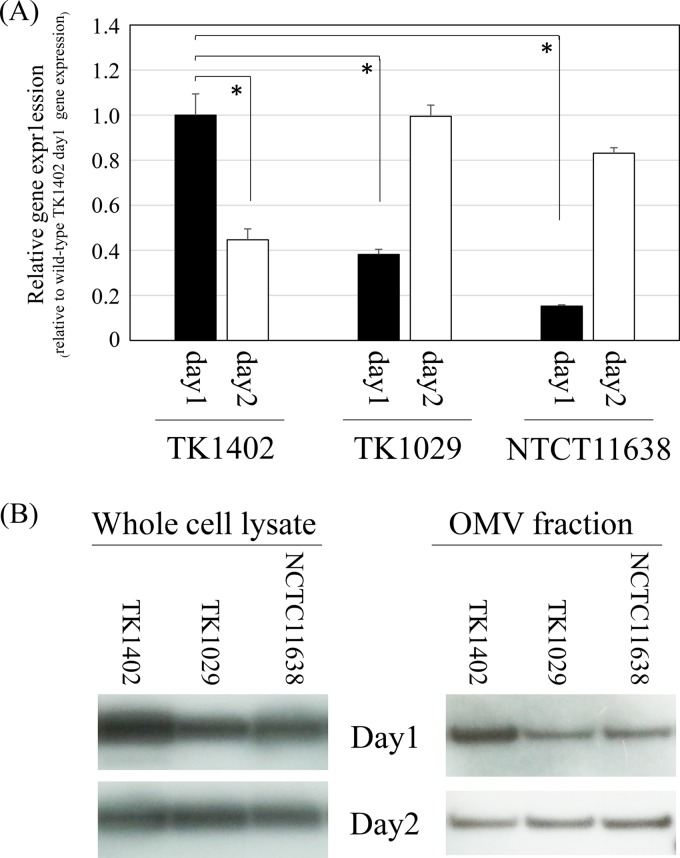
Analysis of alpB gene expression in H. pylori strains TK1402, TK1029, and NCTC11638. (A) The quantity of cDNA corresponding to the alpB gene was determined by real-time PCR and was normalized to that for the 16S rRNA gene. The experiment was repeated three times with at least duplicate samples from independently isolated RNA preparations, and data are expressed as the means from all of the experiments ± 1 standard deviation. An asterisk indicates significant difference (P < 0.05) relative to the mRNA expression level (for TK1402 on day 1 versus TK1402 on day 2, TK1029 on day 1, or NCTC11638 on day 1). (B) A FLAG epitope was inserted into chromosomal alpB at the 3′ terminus in each H. pylori strain, and Western blotting with anti-FLAG monoclonal antibody M2 was performed with cell lysates or OMV of each H. pylori strain.